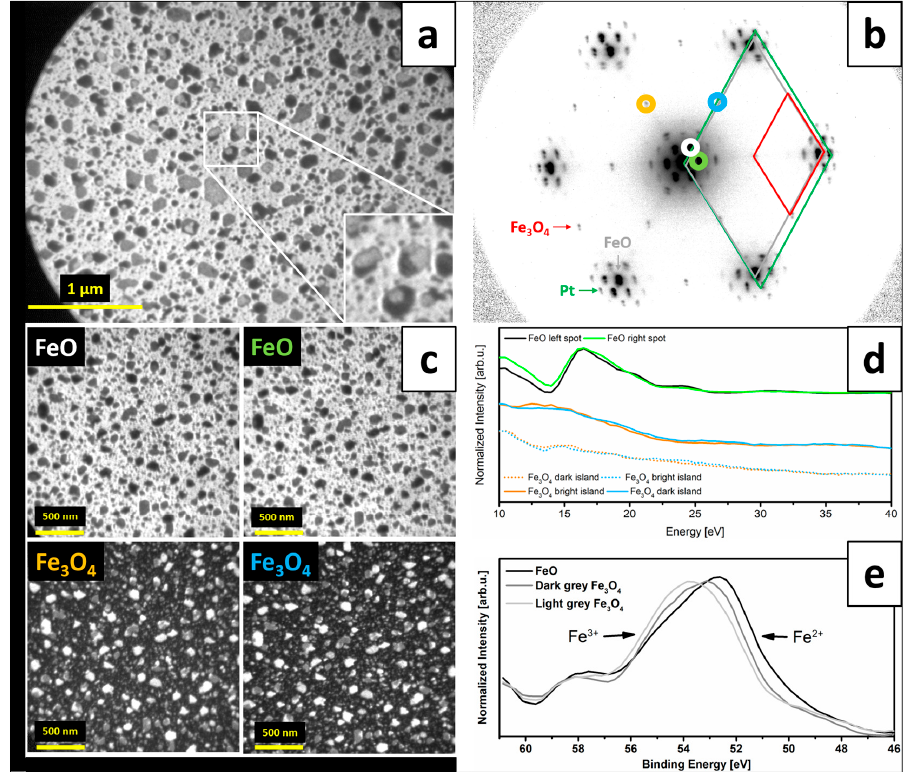
Figure 2. LEEM image (energy: 10 eV) ( a ) and µ LEED pattern (energy: 42 eV) ( b ) of iron oxide structures grown on Pt(111) by ~1.9 MLs Fe deposition under UHV at RT and post-oxidation in 1 × 10 − 6 mbar O 2 at 900 K; the Pt(111), FeO(111) and Fe 3 O 4 (111) unit cells are marked on the µ LEED pattern with green, grey and red rhombuses, respectively; ( c ) presents DF-LEEM images obtained by using the diffraction spots of FeO(111) (imaging energy: 17 eV) and Fe 3 O 4 (111) (10 eV) (marked in colors in ( b )), while ( d ) shows the DF-LEEM-IV curves plotted from stacks of different DF-LEEM images taken at different energies (the corresponding pairs of curves were normalized and the curves were offset for clarity); ( e ) presents the XPEEM-IV data (photon energy: 150 eV) plotted for various surface regions that correspond to different iron oxide structures.